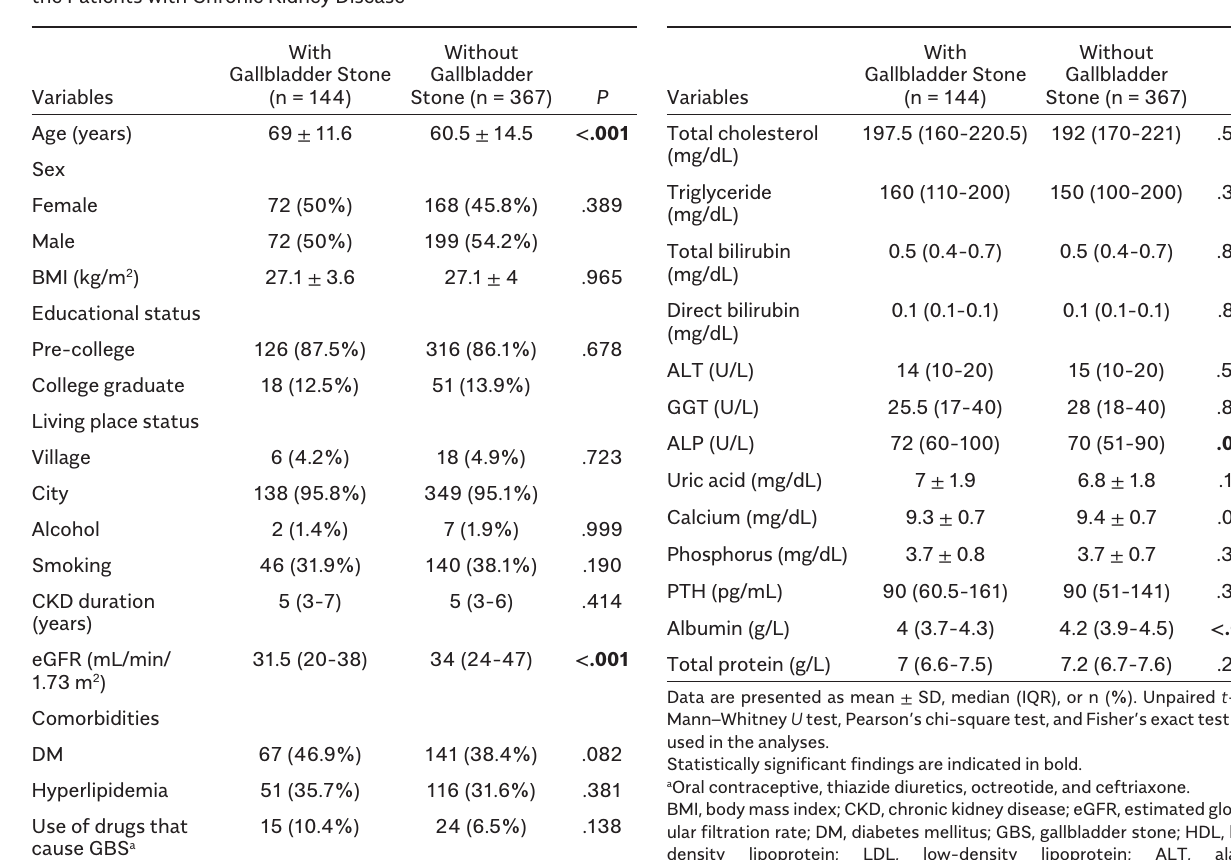
Table 2. Comparison of Demographic and Clinical Characteristics and Laboratory Parameters According to Gallbladder Stone Status of the Patients with Chronic Kidney